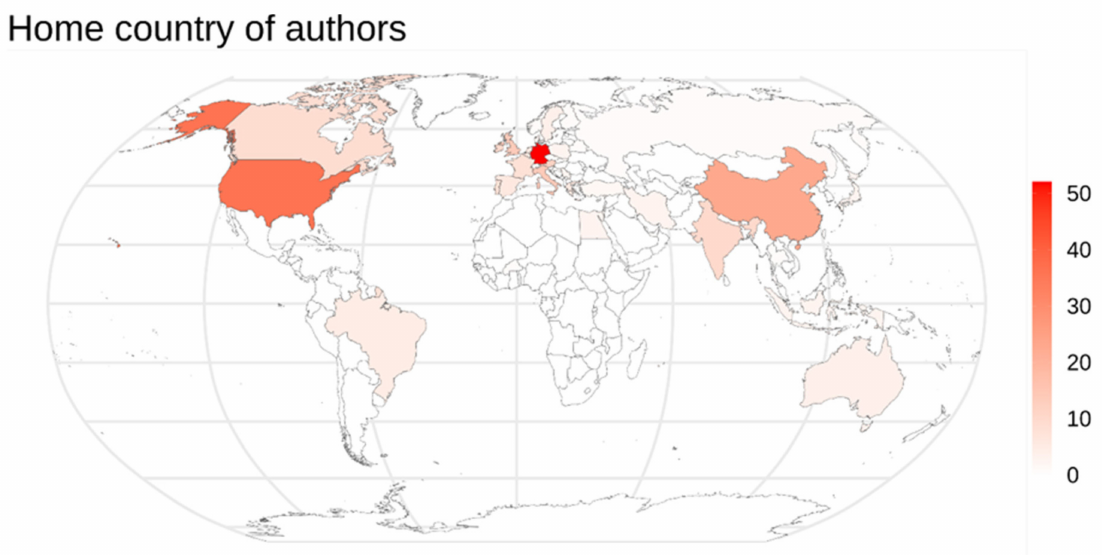
Figure 1. Country map based on the number of OSM-related papers with at least one author with affiliation in those